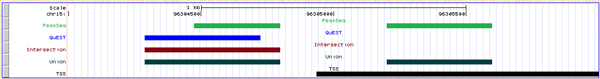
Example of the intersection and union between PeakSeq and QuEST regions.